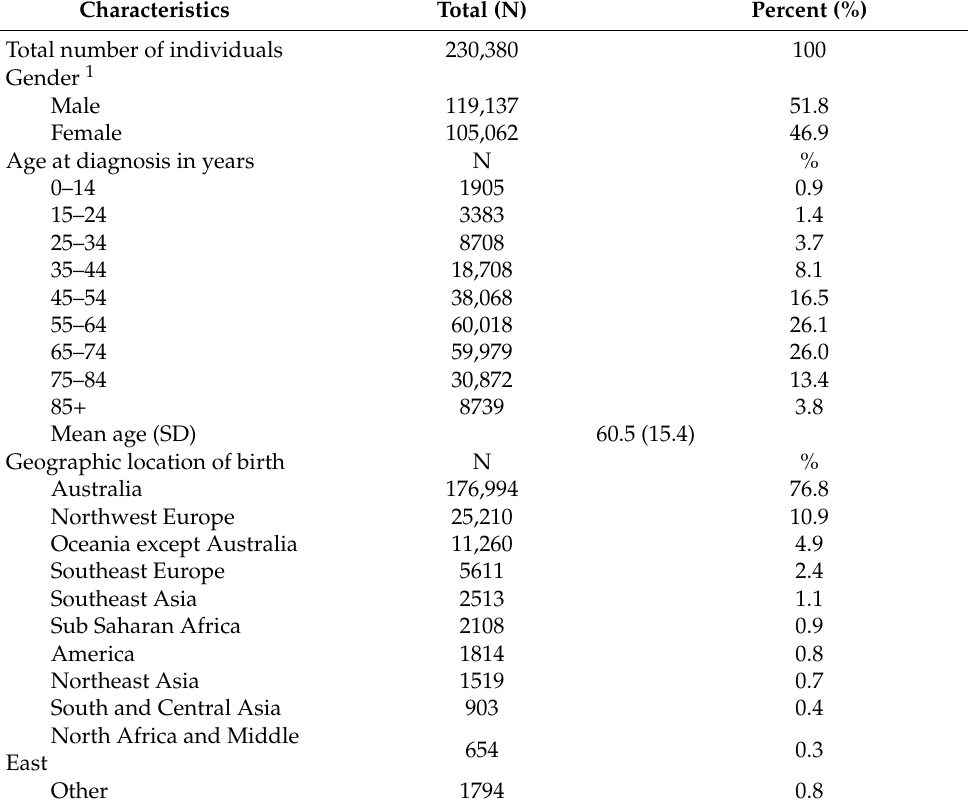
Table 1. Demographics of Queensland Cancer Cohort at time of first primary malignancy